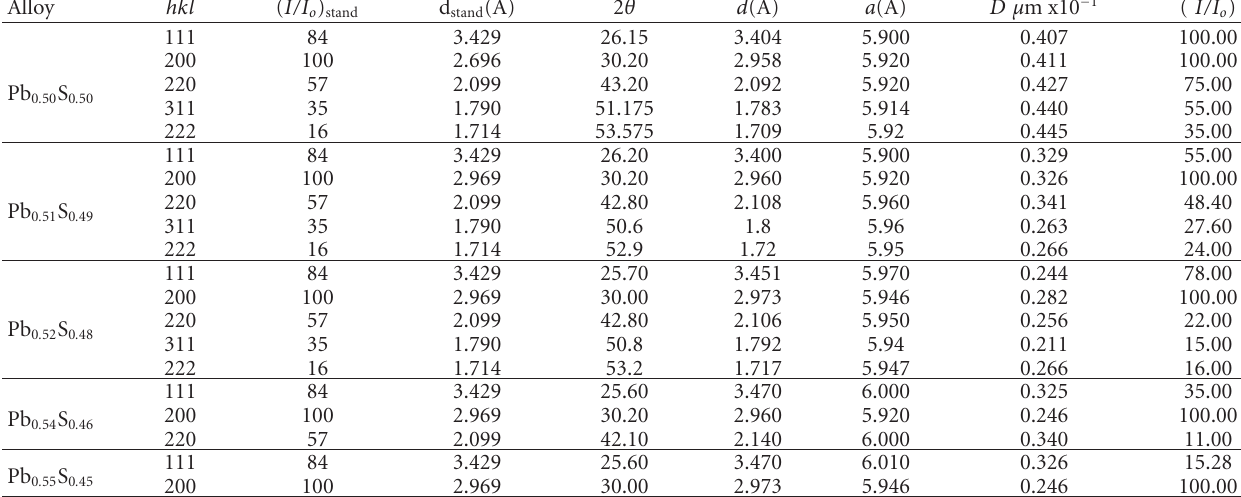
Table 2: X-ray di ff raction data for Pb x S 1 − x alloys as